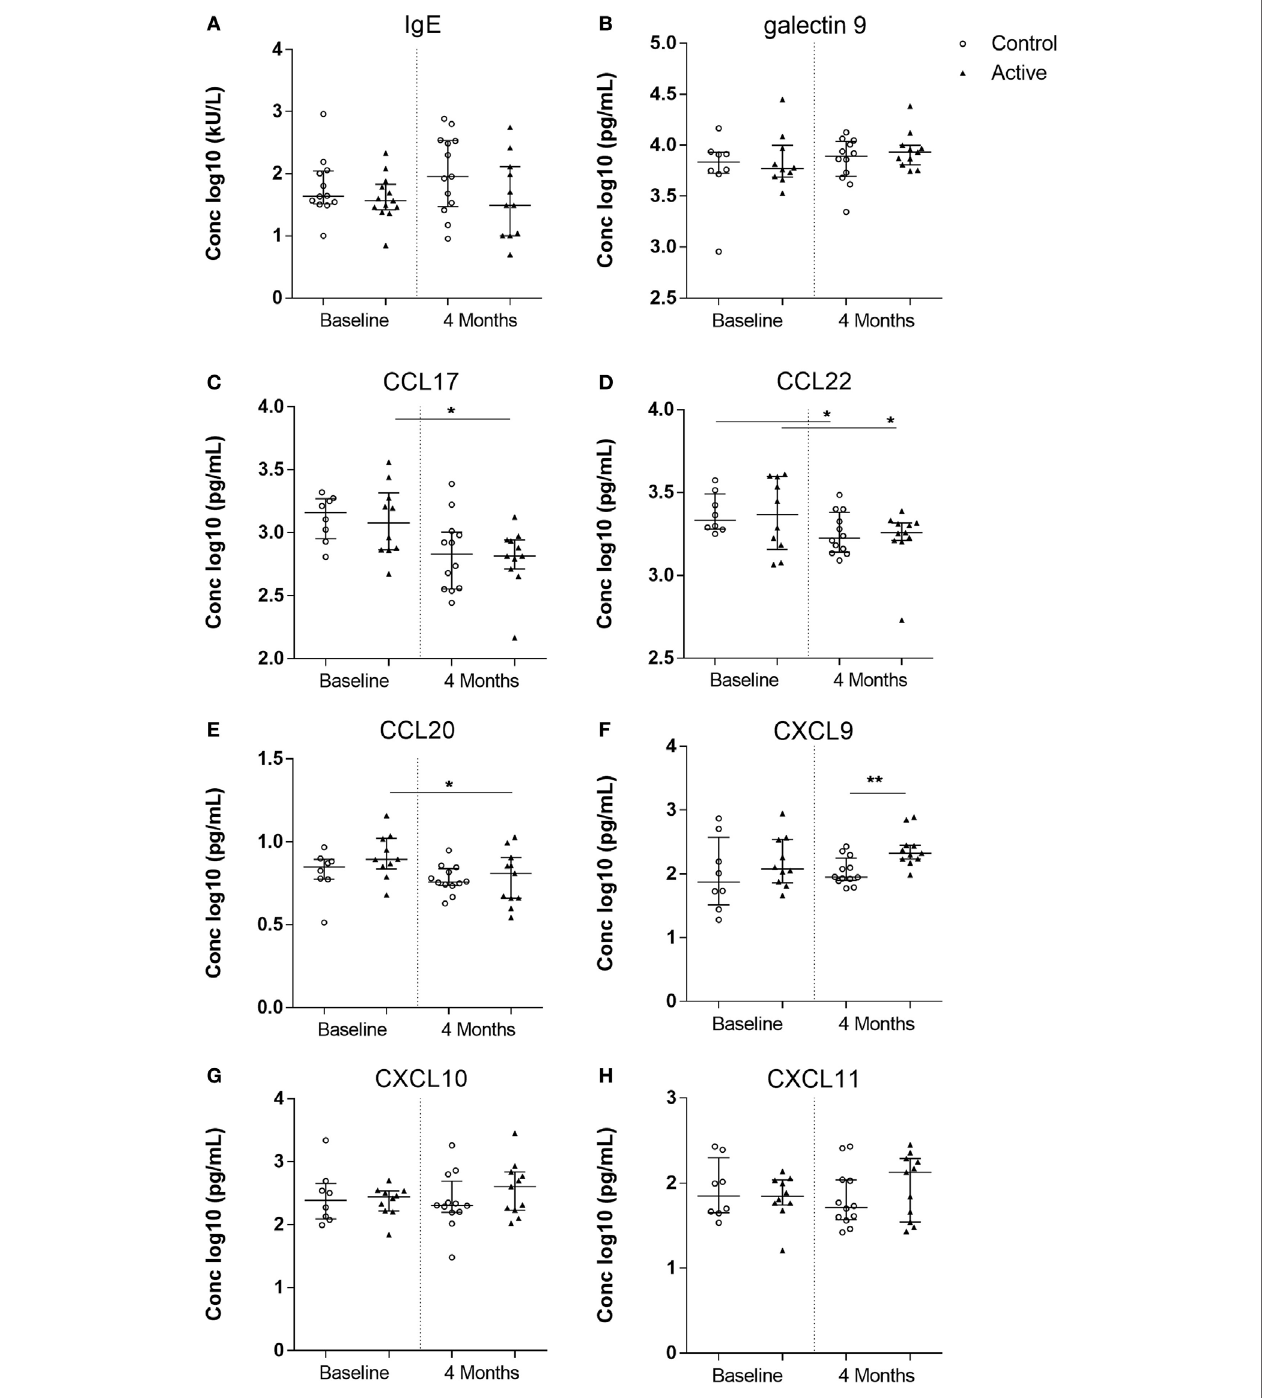
FigUre 3 | Allergy markers measured in serum of the control (open dots, n = 20) and active (closed triangles, n = 21) groups before and after dietary intervention. Immunoglobulin E (IgE) (a) , galectin-9 (B) , CC chemokine ligand (CCL) 17 (c) , CCL22 (D) , CCL20 (e) , CXC chemokine ligand (CXCL) 9 (F) , CXCL10 (g) , and CXCL11 ( h) . Line represents median ± interquartile range. Significant differences within the groups are depicted with asterisks (non-paired W-test, * p < 0.05) and between groups (using Mann–Whitney U -test, ** p <